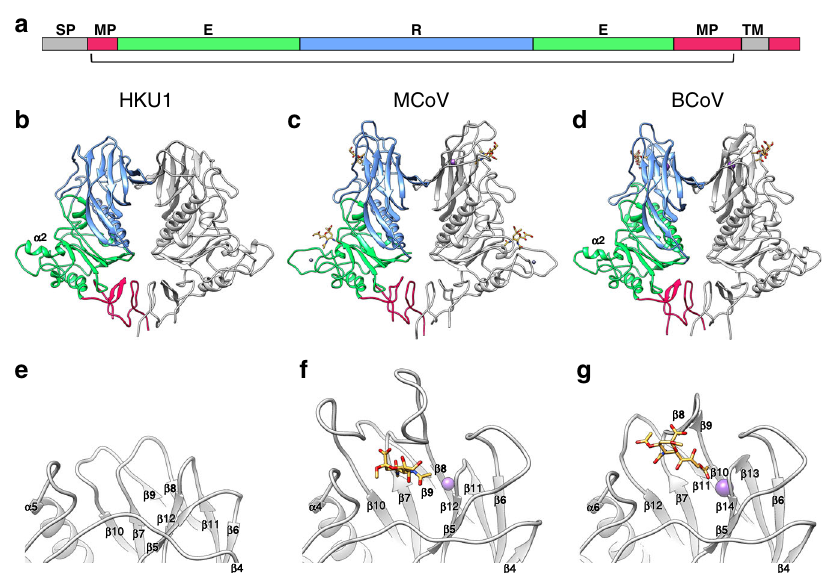
Fig. 2 Comparison of HKU1 HE to related embecoviruses. a Linear representation of HE domain organisation. The membrane-proximal domain (MPD), esterase domain (E) and receptor domain (R) are coloured red, green and blue, respectively. Grey segments indicate the signal- peptide (SP) and transmembrane (TM) domain. The bracket indicates the part of the protein for which the structure of HKU1 HE was solved. b Ribbon representation of the dimeric HKU1-A HE (residues 15 – 346), c MCoV-NJ HE (PDB ID: 5JIL, residues 20 – 388) and d BCoV-Mebus HE (PDB ID: 3CL5, residues 19 – 376) structures. One monomer is coloured grey, the other by domain organisation shown in ( a ). Bound 4-O-acetylated (MCoV) or 9-O-acetylated (BCoV) sialic acid is coloured orange. Sodium (MCoV) and potassium (BCoV) ions are coloured purple and zinc is grey. e Expanded view of the region corresponding to the LD carbohydrate-binding site (CBS) in HKU1 HE, f MCoV, and g